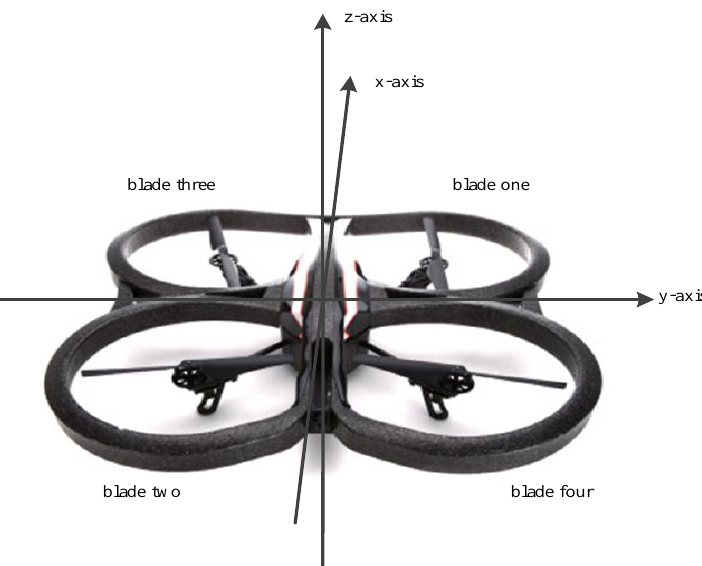
Figure 6. The structure diagram of the quadcopter and the x, y, and z-axis regulations.